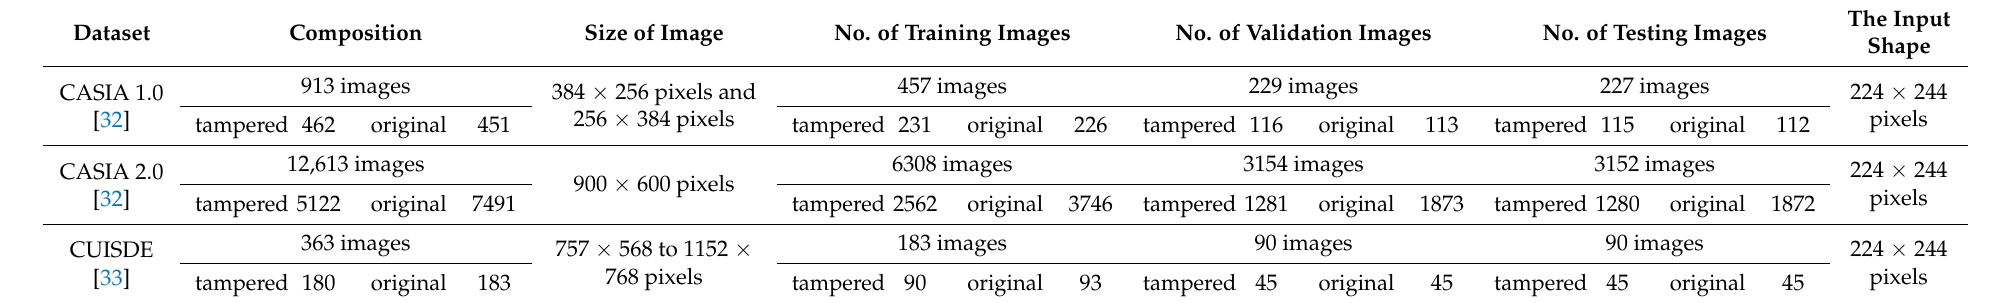
Table 2. The details of the CASIA 1.0, CASIA 2.0, and CUISDE